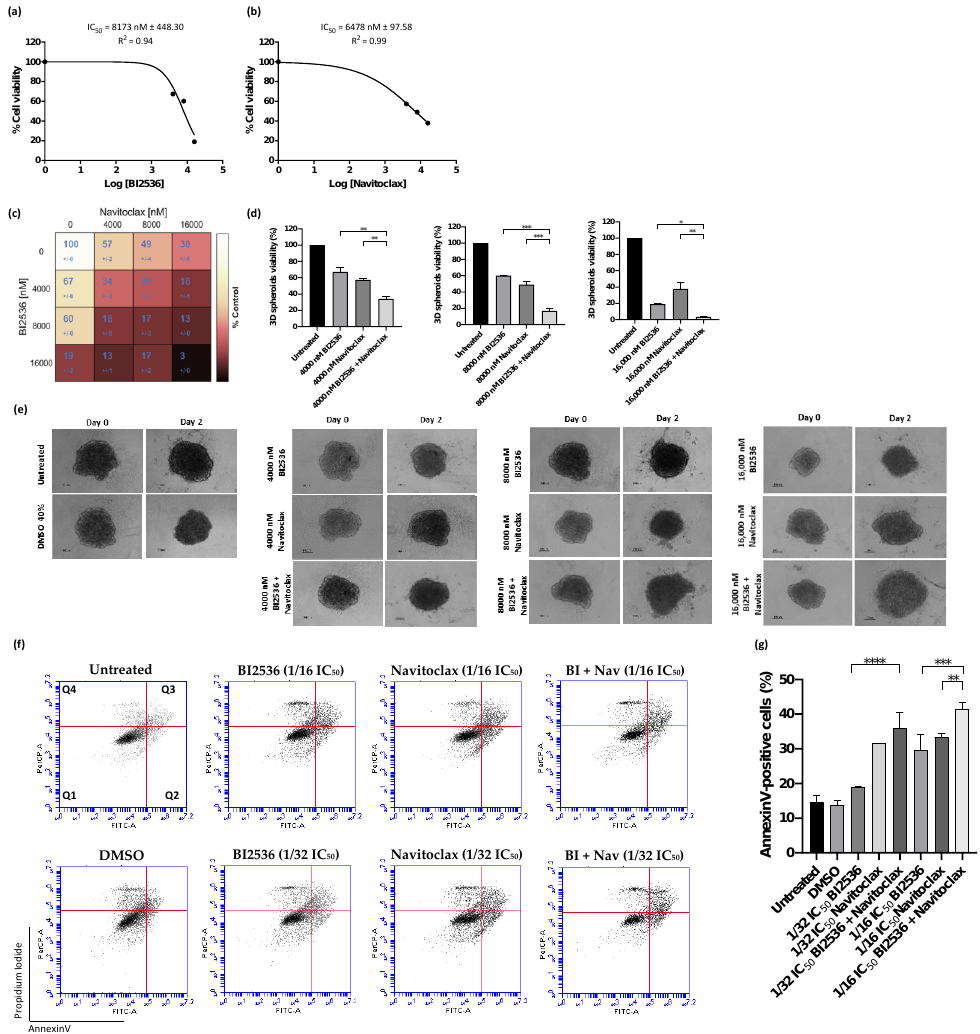
Figure 6. BI2536/Navitoclax combination potentiates 3D spheroid cytotoxicity and cell death. Dose − response curve of BI2536 ( a ) and Navitoclax ( b ) in A549 spheroids. ( c ) Cell viability (%) of single or dual − drug combinations after 48 h of treatment, using the Combenefit software package. ( d ) The combinatory therapy significantly reduced the 3D spheroid viability at the indicated con- centrations. ( e ) Representative images of A549 3D spheroids at days 0 and 2 post-treatment with mono − or BI2536/Navitoclax combinations (100 μm). Representative cytograms ( f ) and quantifica- tion ( g ) of Annexin V − positive cells are shown for A549 cancer cell line. The quadrants Q were de- fined as Q1 = live (Annexin V − and PI − negative), Q2 = early stage of apoptosis (Annexin V − posi- tive/PI − negative), Q3 = late stage of apoptosis (Annexin V − and PI − positive), and Q4 = necrosis (An- nexin V − negative/PI − positive). Data represent the mean ± SD, one-way ANOVA followed by Tukey’s multiple comparisons test, * p < 0.05; ** p < 0.01; *** p < 0.001 and **** p < 0.0001.